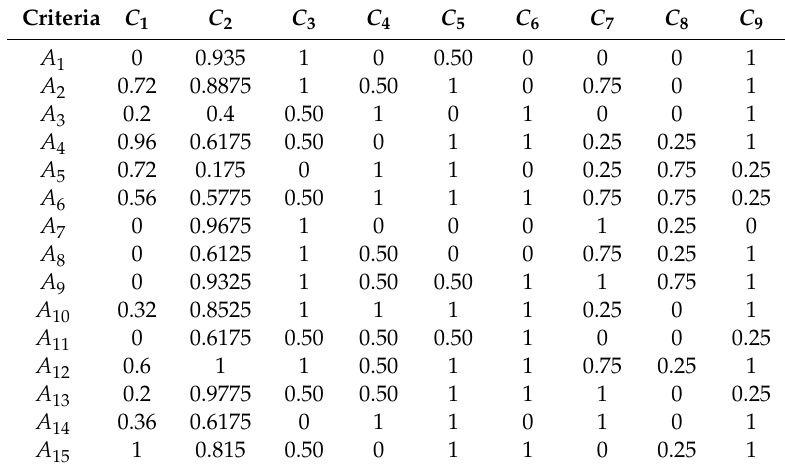
Table 6. Scores for the normalized alternatives against the criteria.